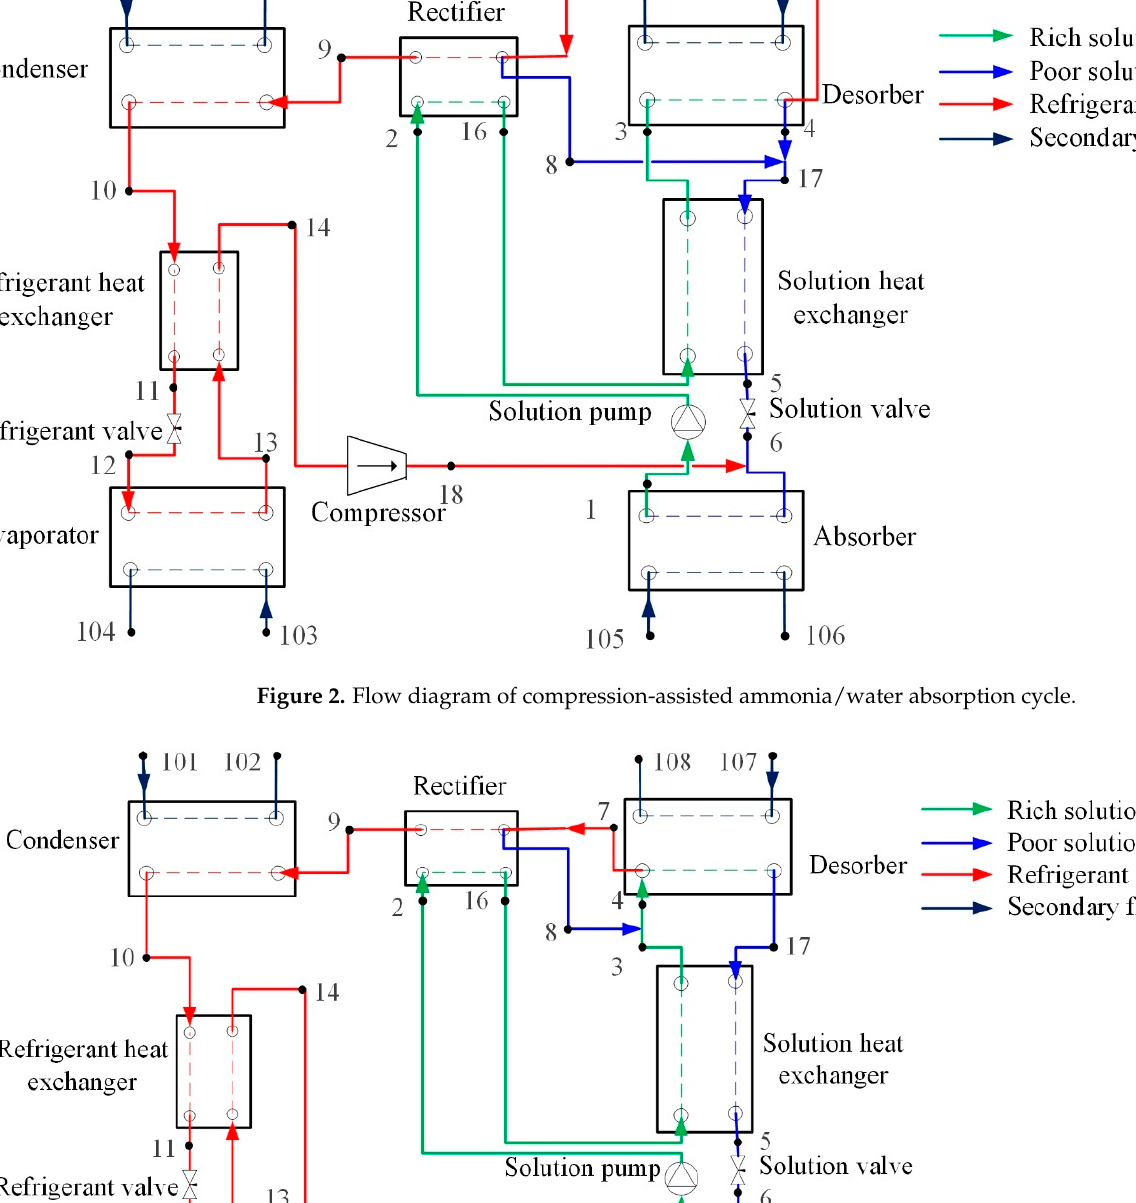
Figure 3. Flow diagram of ammonia/water absorption cycle with counter-current desorber.